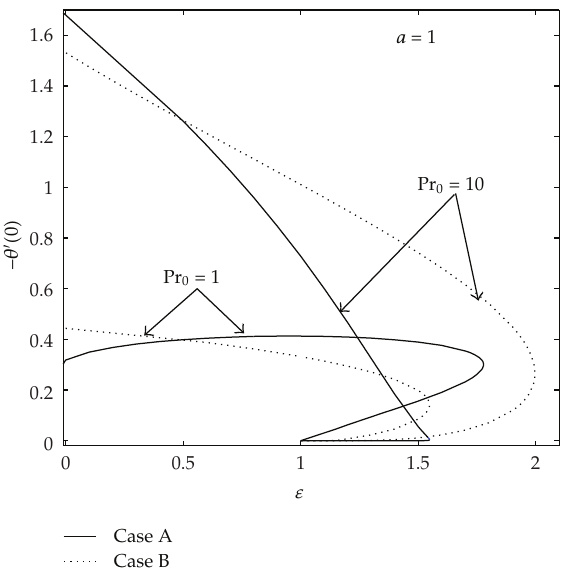
Figure 2: Variation of the reduced heat flux − θ (cid:4) (cid:5) 0 (cid:6) with ε for di ff erent values of Pr 0 when a (cid:8) 1. Case A (cid:5) solid line (cid:6) : constant viscosity and Case B (cid:5) dotted line (cid:6) : inversely linear viscosity, (cid:5) 3.5 (cid:6) , and (cid:5) 3.6 (cid:6)